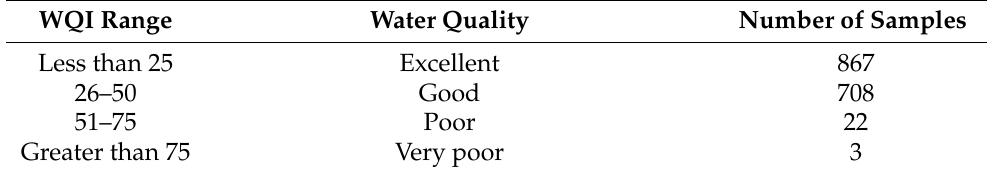
Table 5. Water quality classification.